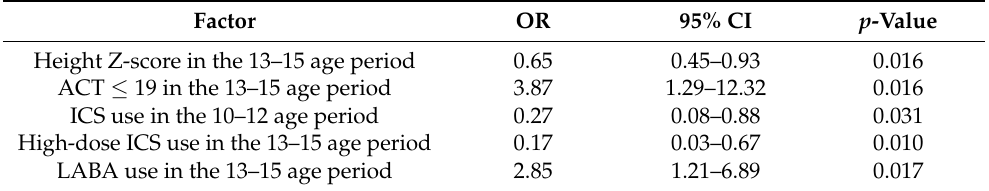
Table 4. Factors associated with unfavorable lung function trajectories by multivariate logistic regression